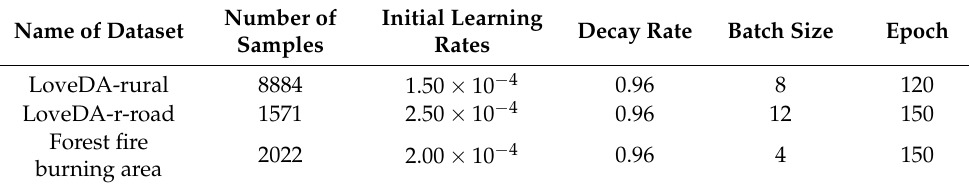
Table 4. Parameter